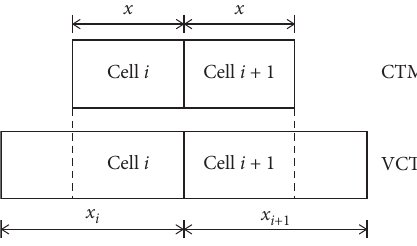
Figure 8: Cell diagram of CTM and VCTM.